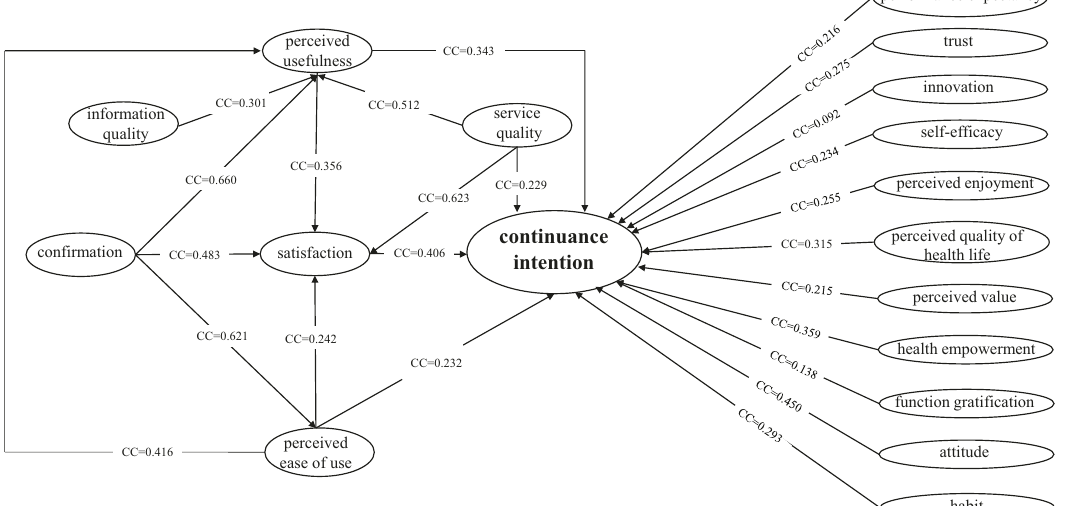
Fig. 3 Path diagram of the in fl uence relationship between variables. Drawing a path diagram for all the in fl uence relationships with signi fi cant pooled effects, including 15 direct and 9 indirect in fl uence relationships on continuance intention. Notes: CC = Combined coef fi cient.